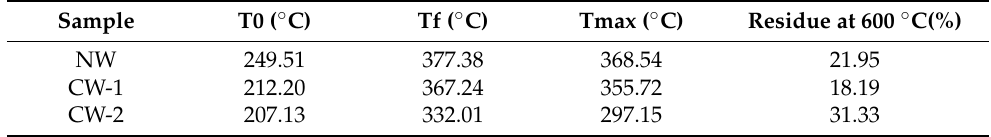
Table 1. The rmogravimetric data of NW and CW.